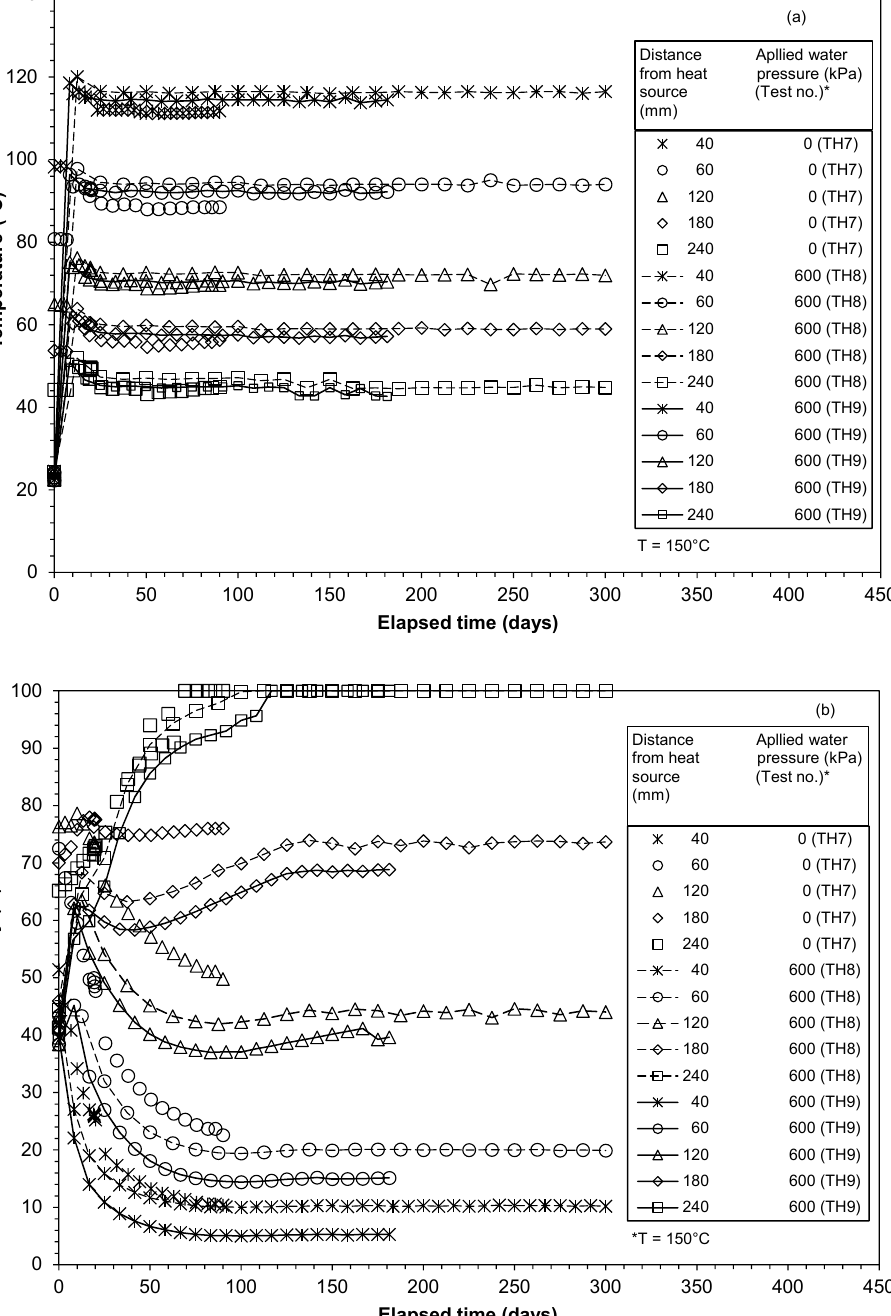
Figure 9. Effects of simultaneous thermal and hydraulic gradients (85 °C, bottom; and 25 °C, top; and water pressure from top = 600 kPa or 5 kPa) on the distributions of: ( a ) temperature; ( b ) relative humidity in compacted bentonite specimens (diameter 100 mm, height 300 mm).